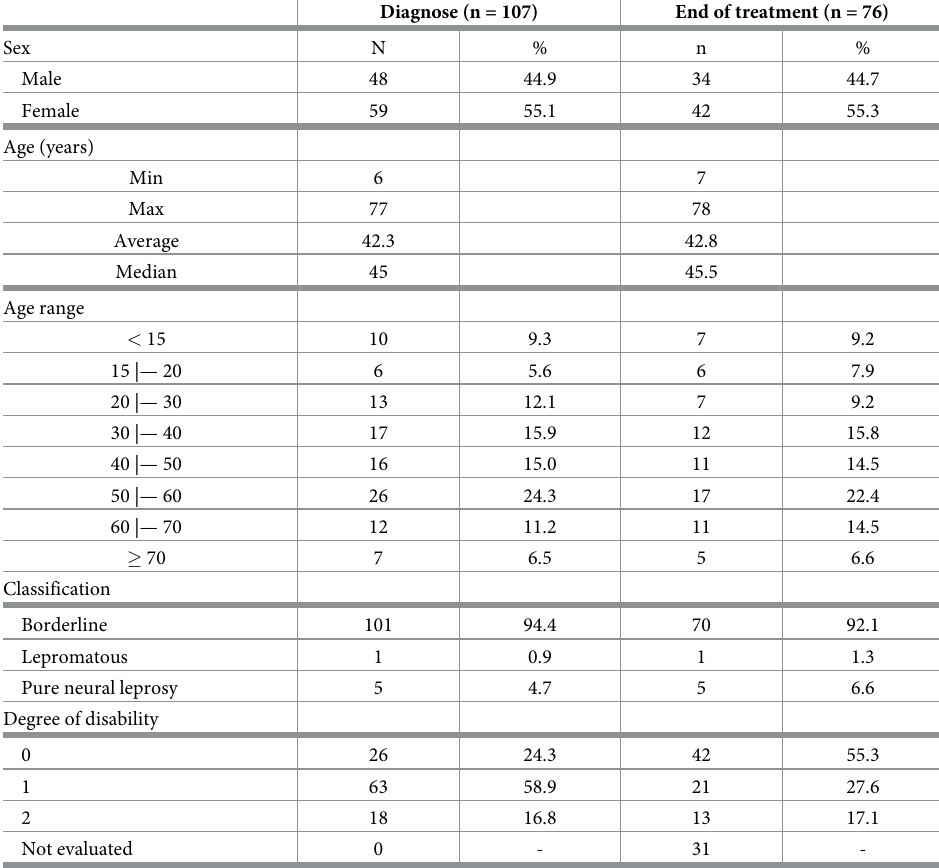
Table 2. Demographic characterization and clinical classification of patients.